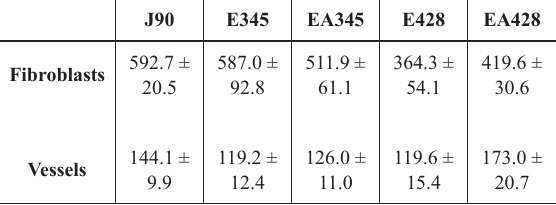
Figure 1 - Photomicrographies from random regions of the periodontal ligament of rats in groups: (A) J90 (90-day-old young rats), (B) E345 (345-day-old aged rats), (C) EA345 (345-day-old aged rats treated with ascorbic acid since 90-day-old), (D) E428 (428-day-old aged rats) and (E) EA428 (428-day-old aged rats treated with ascorbic acid since 90-day-old). Stained with hematoxylin and eosin. Calibration bar: 50 µm.